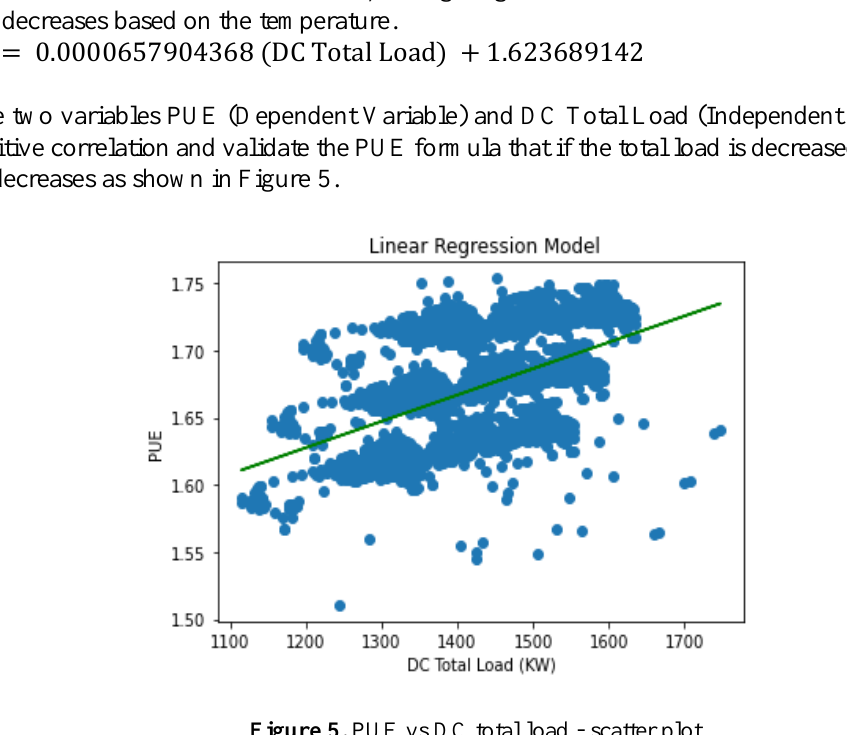
Figure 5. PUE vs DC total load - scatter